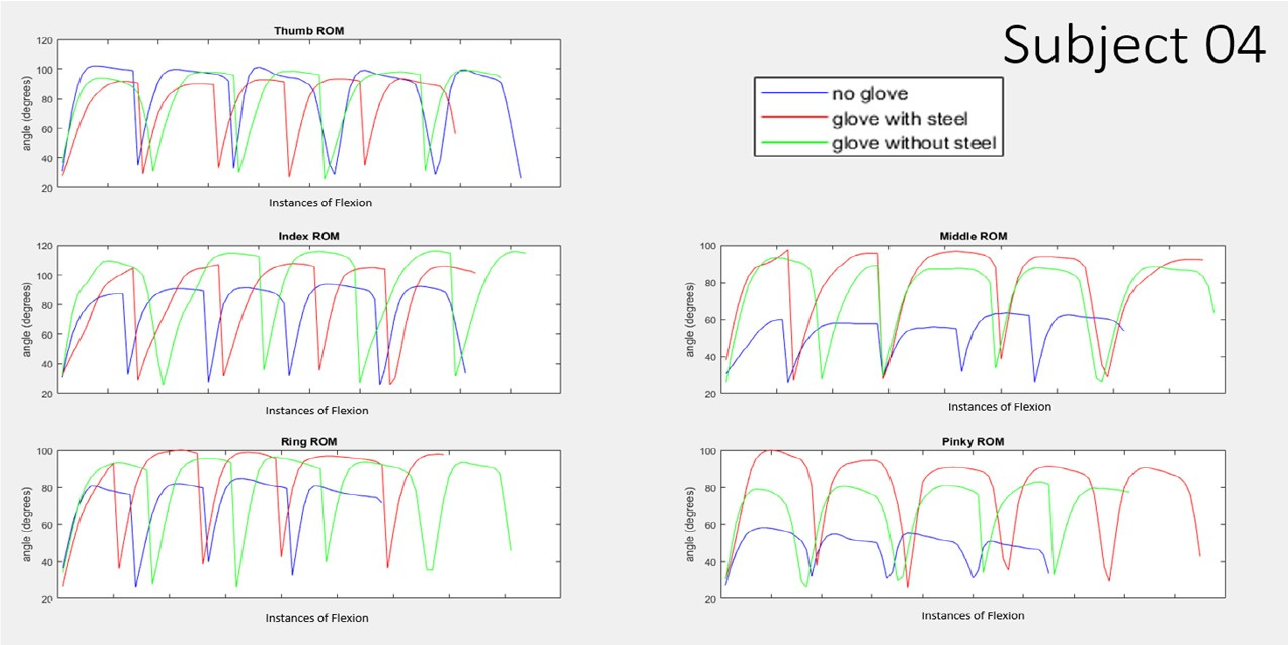
Figure 9. Range of Motion for 5 nonsequential instances of participant actuated finger curling with no pneumatic assistance for 3 different conditions of wearing no pneumatic glove (shown in blue), wearing the pneumatic glove with steel inserts (shown in red), and wearing the pneumatic glove without the steel (shown in green) for subject 04.